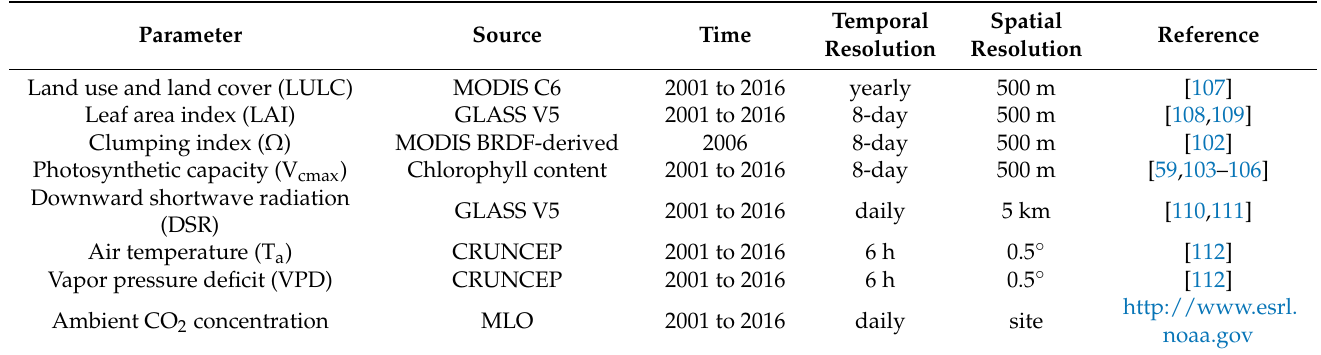
Table 3. Vegetation and environmental inputs for the FGM from 2000 to